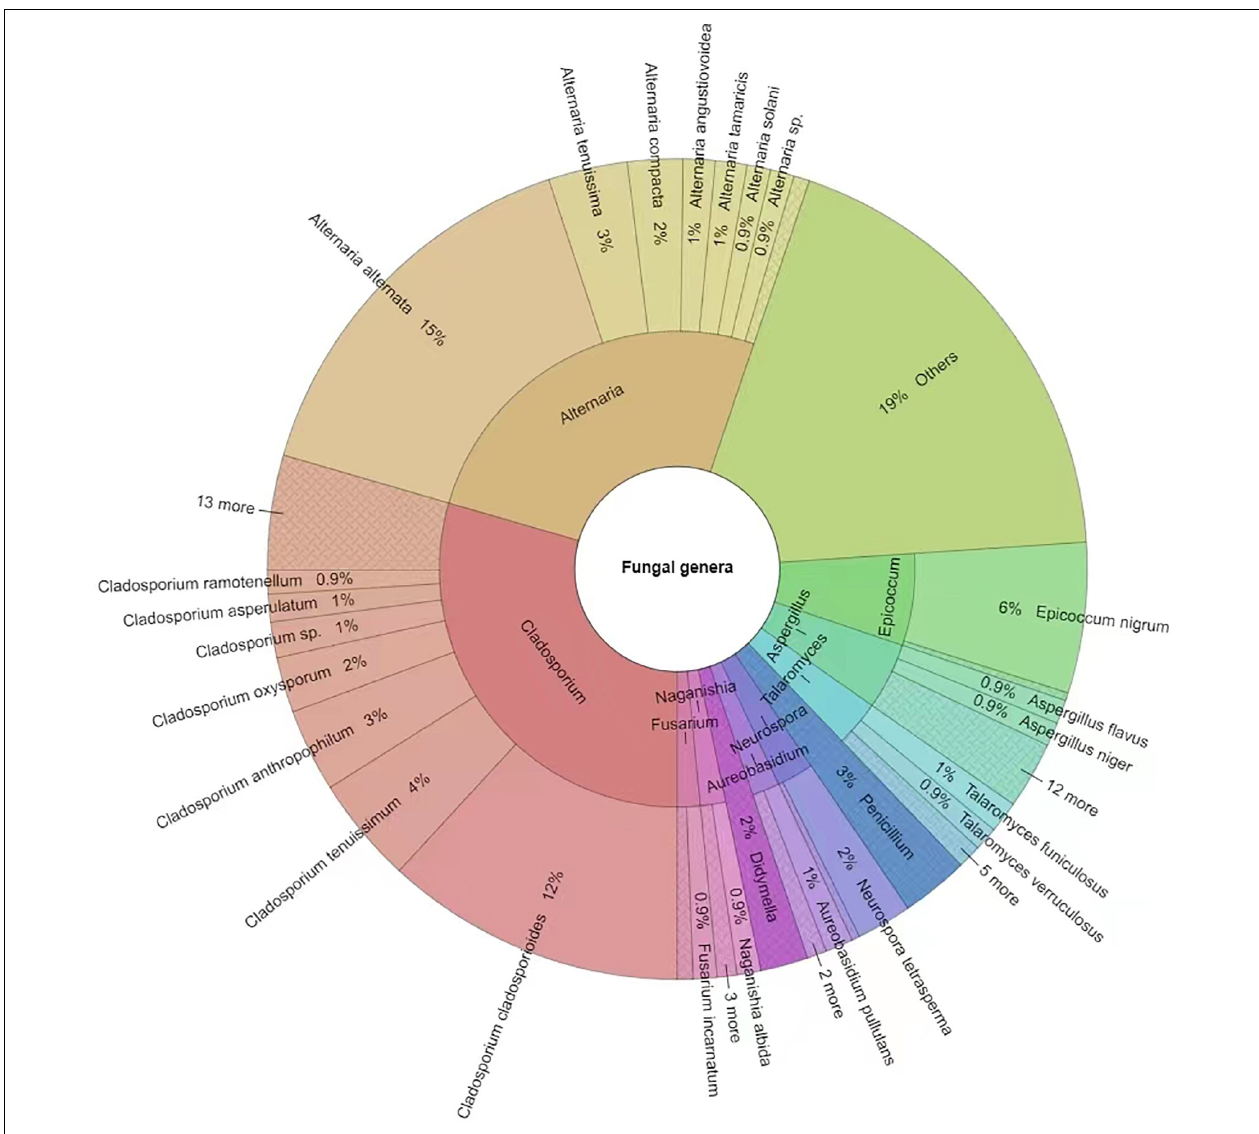
FIGURE 6 | Krona chart indicating the dominant fungal genera and species isolated in this study. Others = strains < 1%. Round values are reported.